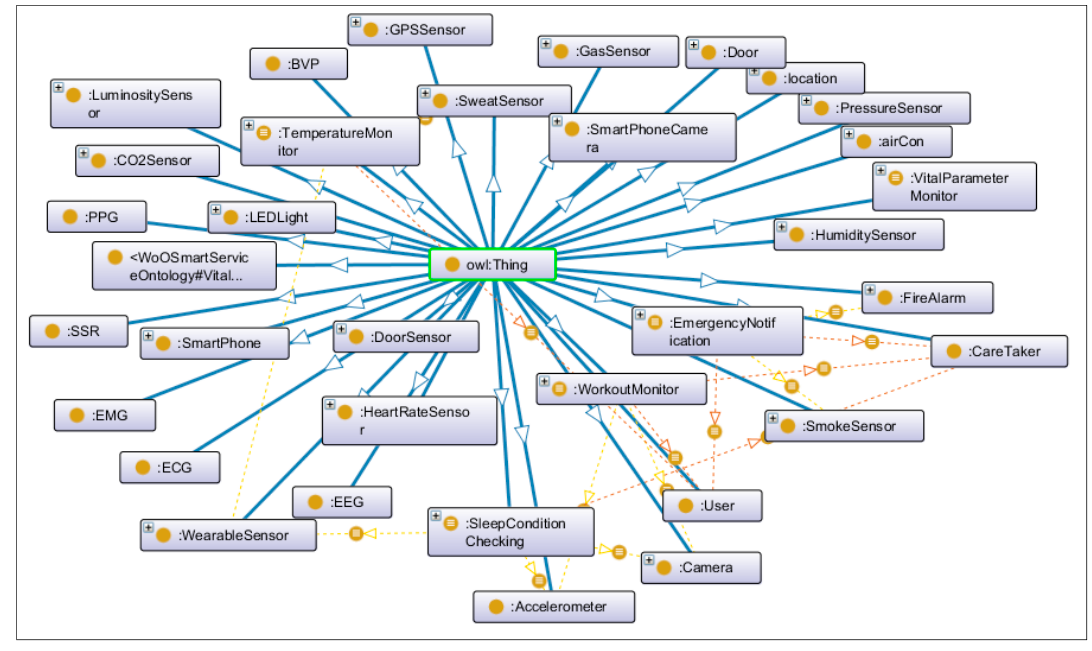
Figure 14. Semantic ontology for the proposed design.